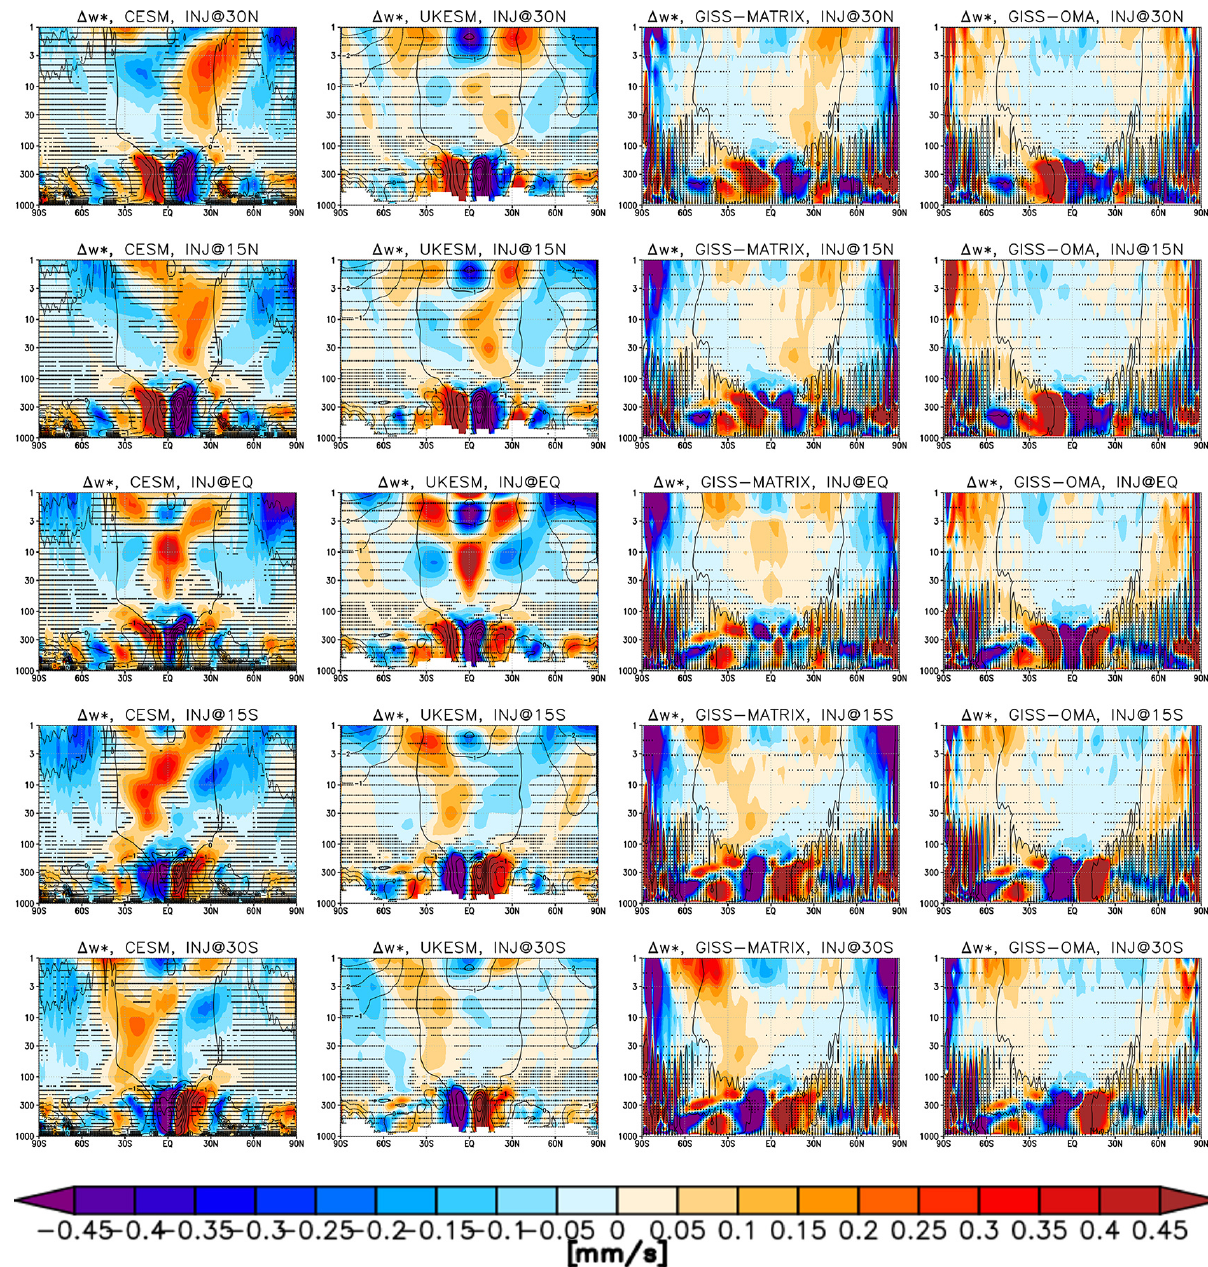
Figure 6. Shading: yearly mean changes in transformed vertical velocity [mms − 1 ] averaged over the last 8 years of the simulations compared to the same period in the SSP2–4.5 run for CESM (column 1), UKESM (column 2), GISS-MATRIX (column 3), and GISS-OMA (column 4). Positive values indicate anomalous upwelling. Contours show the vertical velocities in the control SSP2–4.5 run for reference (note that for GISS-MATRIX and GISS-OMA only the 0 contour is plotted for clarity). Stippling as in Fig.